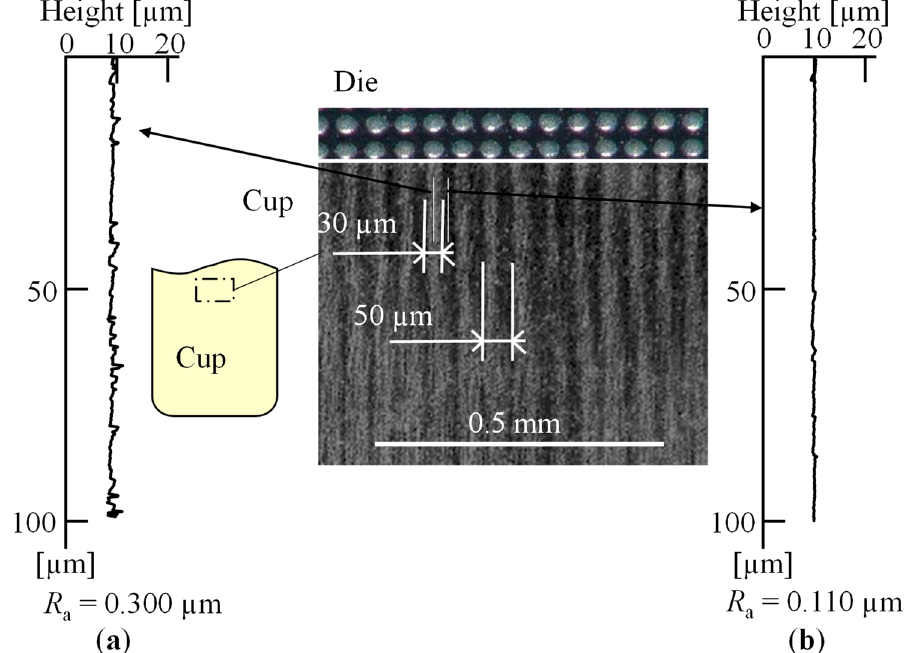
Figure 17. The die surface before ironing and the cup surface obtained after ironing with a grid array pa tt ern having d = 30 µm, h = 2 µm, and L = 50 µm, applying a lubricant containing extreme pressure additive at r = 17%; surface roughness and 2D pro fi les ( a ) on pocket marks, and ( b ) outside pocket marks.